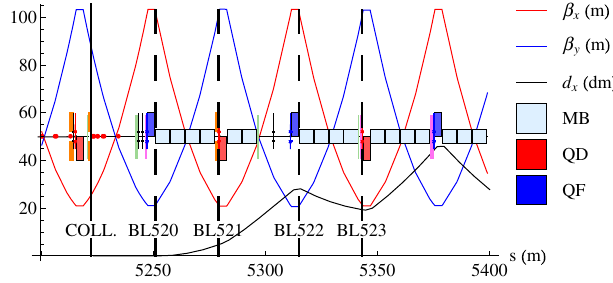
FIG. 4. (Color) The (cid:4) functions of the SPS downstream of the collimator and the locally generated dispersion d x from the collimator. We show also the magnetic elements ( MB ¼ main bend, QF ¼ focusing quadrupole, QD ¼ defocusing quadrupole). The BLMs and the collimator are in- dicated by vertical lines.